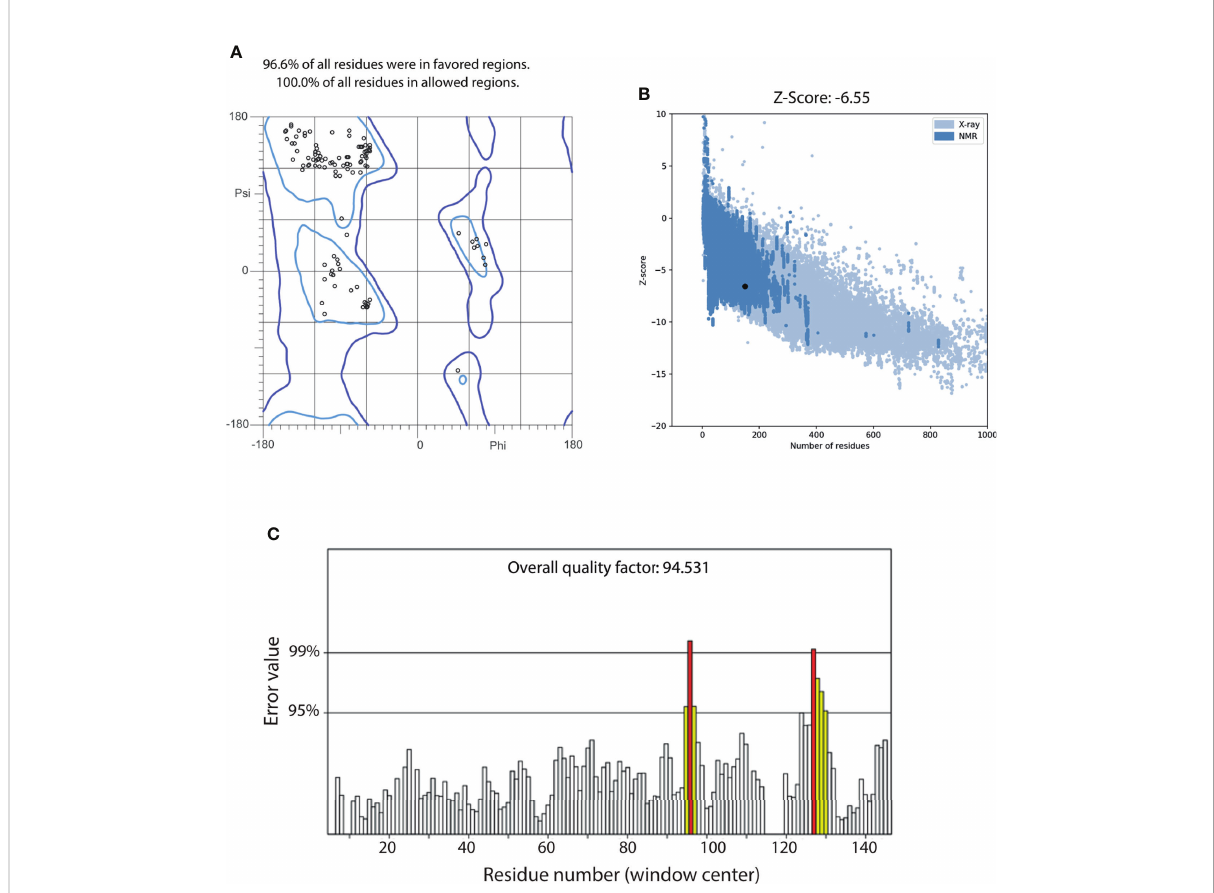
FIGURE 7 Quality assessment of the re fi ned centroid of MEP_12 most populated cluster. (A) Ramachandran plot of MEP_12 centroid, indicating the percentage of residues in favored (light blue) and allowed (blue) regions. (B) Scatterplot of the Z-scores of MEP_12 centroid (black dot) and structures with experimental evidence obtained from NMR (blue) and X-ray crystallography (light blue). (C) ERRAT plot of MEP_12 centroid. Bars represent the error value (white: error < 95%, yellow: 95%, error < 99%, red: error > 99%) of a nine-residue sliding window. The overall quality factor indicates the percentage of protein residues with error values lower than